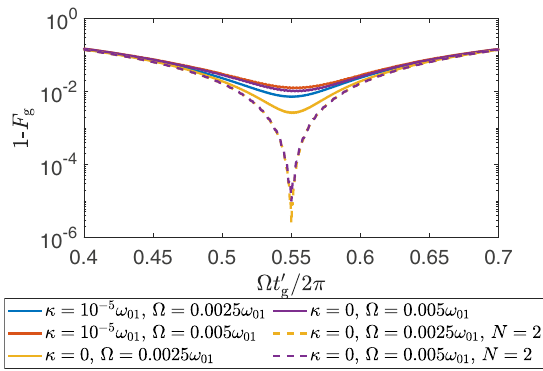
Fig. 7 The in fi delity of a simple NOT-gate. The average in fi delity of a simple NOT-gate with different drive amplitudes and bath coupling strengths calculated using the Red fi eld equation for N = 5 (solid lines) and N = 2 (dashed lines). Here t 0 have used β ℏ ω 01 = 10, E J / E C = 100 and t r = t g /20.